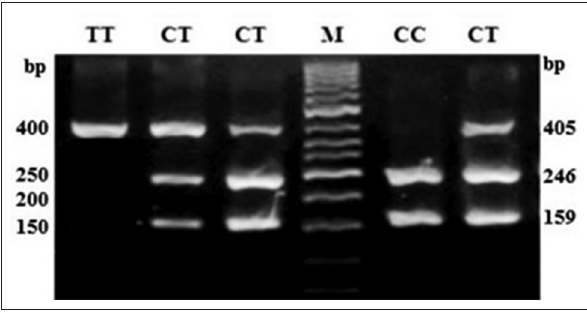
Figure-4: Polymerase chain reaction-restriction fragment length polymorphism profile